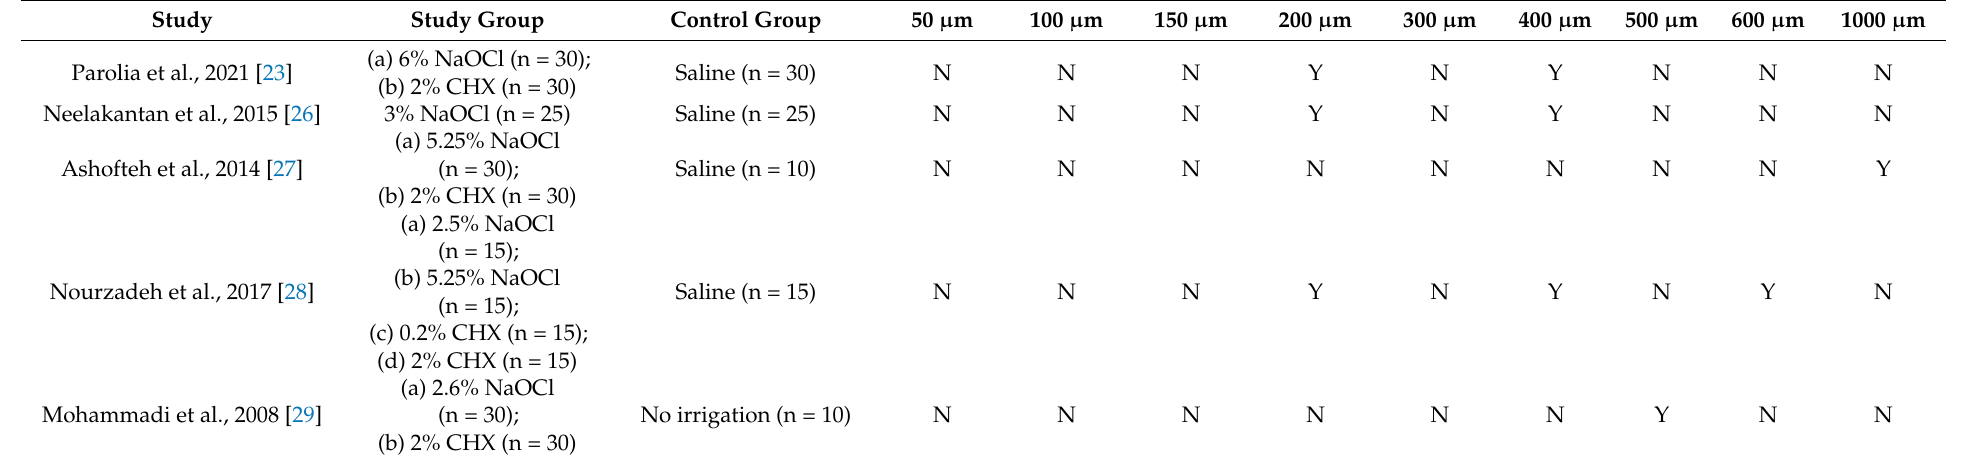
Table 4. Summary of dentinal shavings